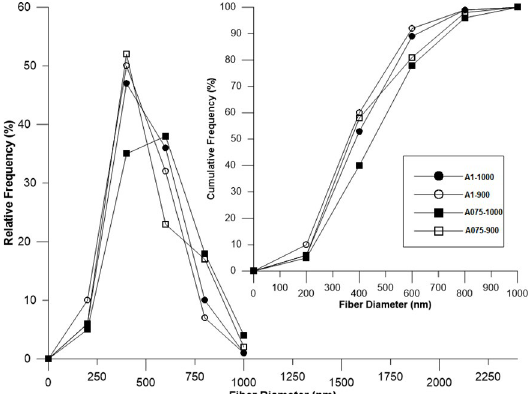
Figure 7. Fluorescence after 24 hours in contact with peripheral blood mononuclear cells